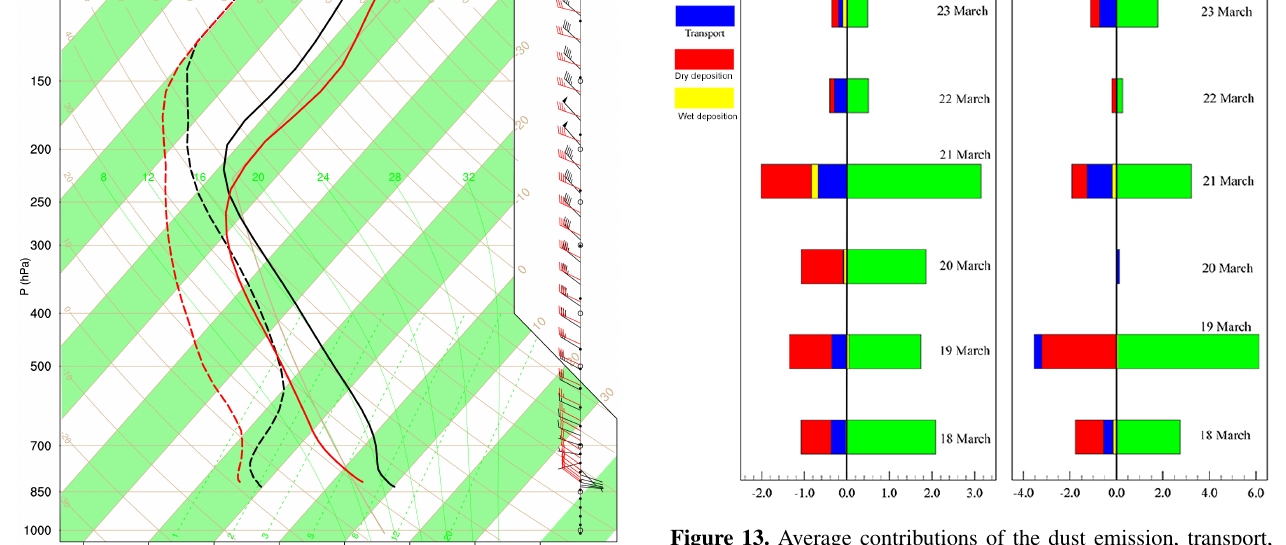
Figure 13. Average contributions of the dust emission, transport, and dry and wet deposition to the dust mass balances over the TD and GD during the simulation period based on the WRF-Chem model. A positive sign represents an increase in dust concentra- tion, and a negative sign represents a decrease in dust concentration. Units: tons × d − 1